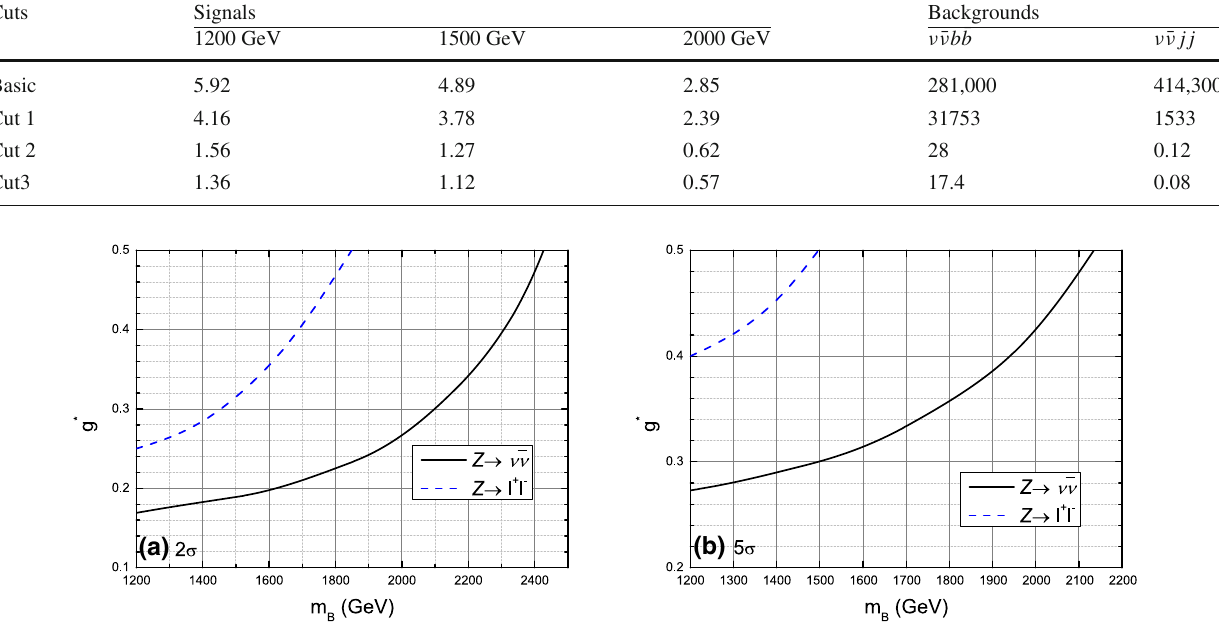
while the discovery region can reach g ∗ ∈ [ 0 . 4 , 0 . 5 ] and m B ∈ [1200 GeV, 1500 GeV]. While for Z → ν ¯ ν decay channel,theVLQ- B quarkmasscanbeexcludedintheregion of g ∗ ∈ [ 0 . 17 , 0 . 5 ] and m B ∈ [1200 GeV, 2400 GeV] and the discovery region can reach g ∗ ∈ [ 0 . 27 , 0 . 5 ] and m B ∈ [1200 GeV, 2150